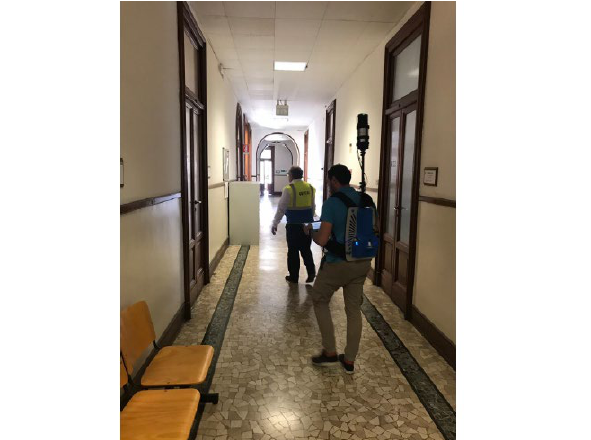
Figure 2: Particular of the acquisition procedure